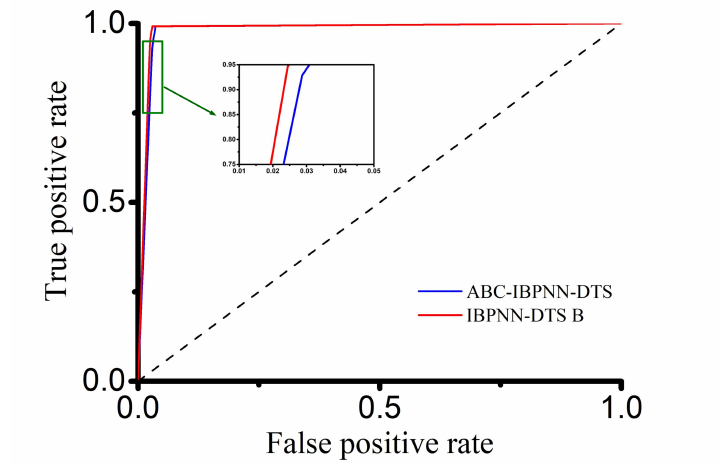
Figure 12. ROC curve of IBPNN-DTS B models before and after